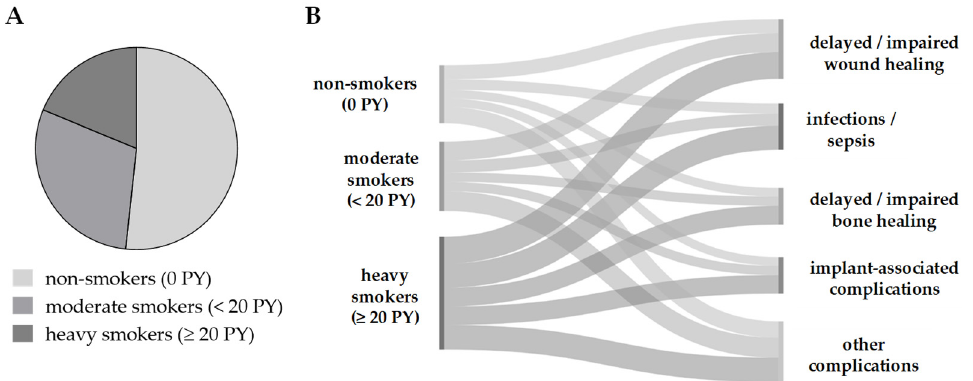
Figure 3. Effect of smoking on the complication rate in patients following orthopedic and trauma surgery. Data on smoking behavior and post-surgical complications from 2318 representative patients at a level 1 trauma center have been obtained from the hospital information system. ( A ) Smoking was recorded as packyears (PY): 51.3% of the patients claimed to be non-smokers (0 PY), 29.5% of the patients were considered as moderate smokers (<20 PY), and 18.8% of the patients were considered as heavy smokers ( ≥ 20 PY). ( B ) Complications were summarized as groups and are presented in a cord diagram (made with SankeyMATIC, https://sankeymatic.com/build/, accessed on 20 October 2022), where the cord width equals the complication rate in % within the individual group (non-, moderate, or heavy smokers).